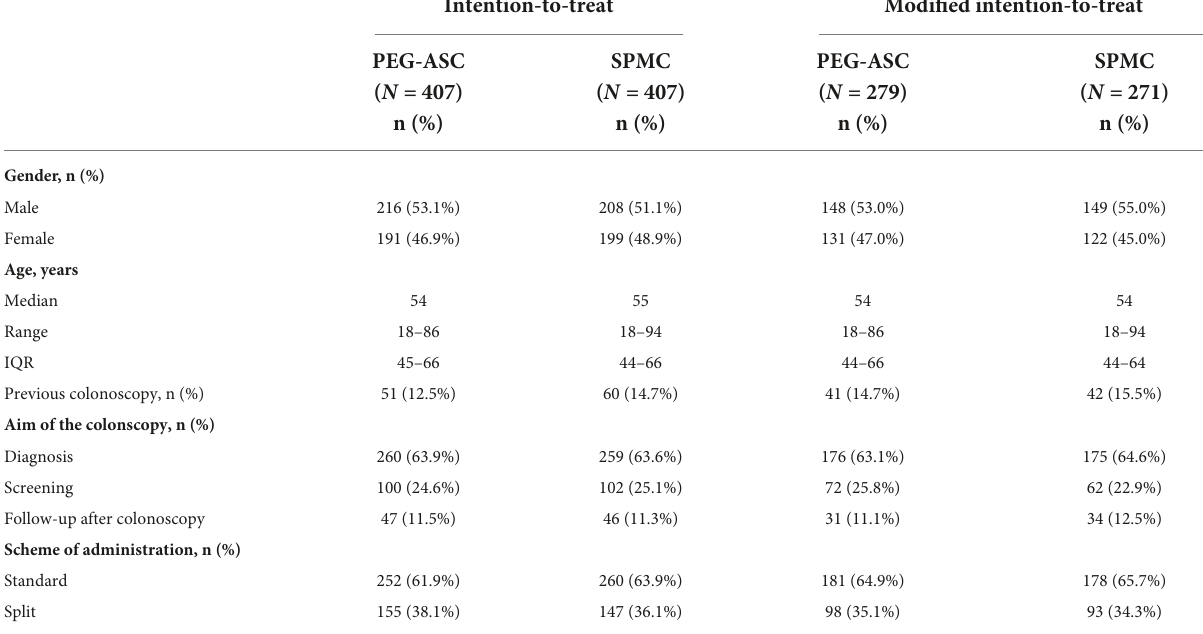
TABLE 1 Baseline data of intention-to-treat (ITT) and modified intention-to-treat (mITT) populations by assigned